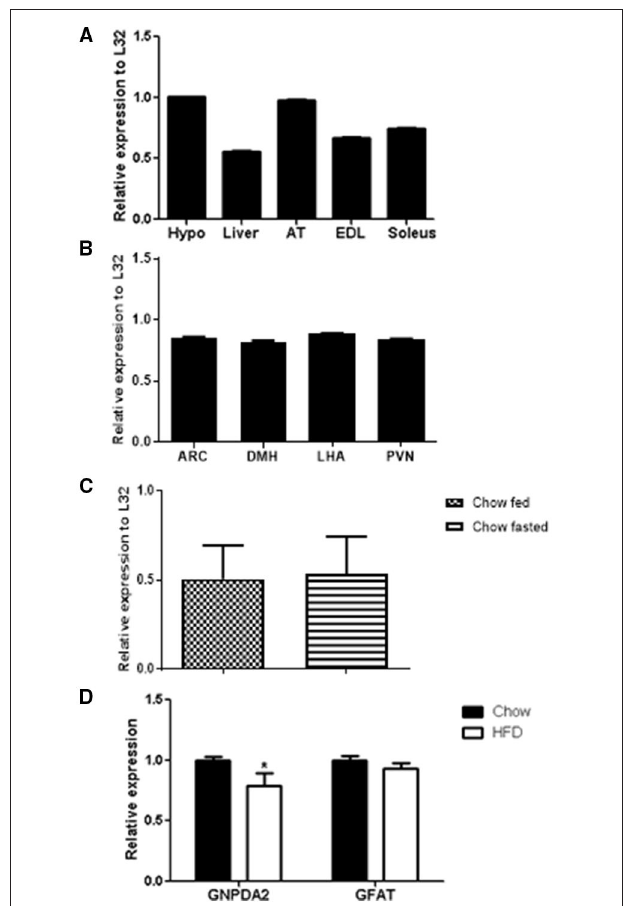
FIGURE 1 | GNPDA2 mRNA expression levels in different tissues and diets. (A) GNPDA2 mRNA levels in hypothalamus (hypo), liver, adipose tissue (AT), extensor digitorum longus (EDL) and soleus muscle. (B) GNPDA2 mRNA levels in arcuate nucleus of the hypothalamus (ARC), dorsomedial nuclei of the hypothalamus (DMH), lateral hypothalamic area (LHA) and paraventricular nuclei (PVN). (C) Hypothalamic GNPDA2 mRNA levels of fasted (48h) vs. fed (2h) animals under chow diet. (D) Hypothalamic GNPDA2 and GFAT mRNA levels on chow and high-fat diet. Relative expression calculated by the 11 Ct method was normalized by L32, a housekeeping gene. The expression data were analyzed using a t -test * P < 0.05. n = 15 rats per